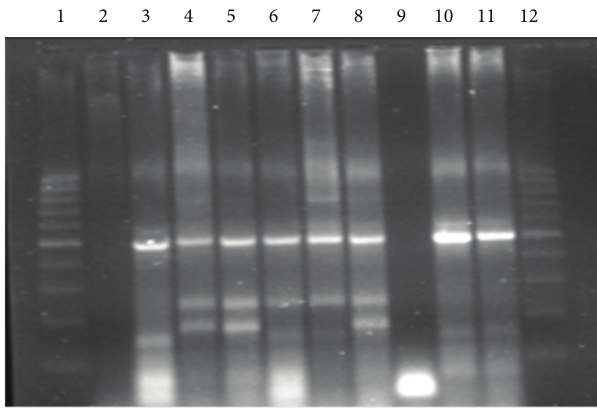
Figure 2: Amplification products from multiplex PCR analysis for Beijing strains of M. tuberculosis . Lanes 1 (100bp DNA ladder), 2, and 9 (negative control and amplification control), lanes 4 (Q08), 5 (Q07), 6 (Q06), 7 (Q06), and 8 (ZT71) contain three-fragment pattern characteristic for strain W and lanes 3 (ZT67), 10 (ZT67), and 11 (H37Rv) contained only two fragments generated by internal positive control